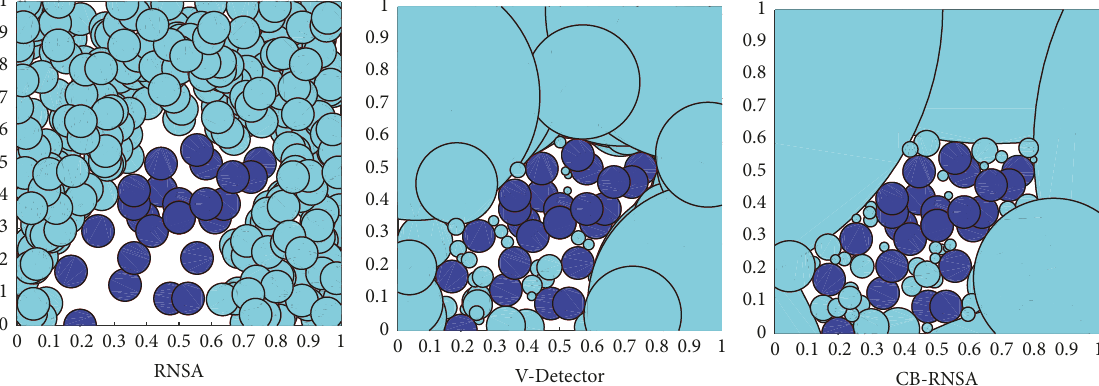
Figure7:ContrastbetweenCB-RNSA,RNSA,andV-Detector(toachievetheexpectedcoveragerate90%,RNSA,V-Detector,andCB-RNSA need 357, 81, and 35 mature detectors, respectively, where the self radius is 0.05, and the detector radius of RNSA is 0.05).